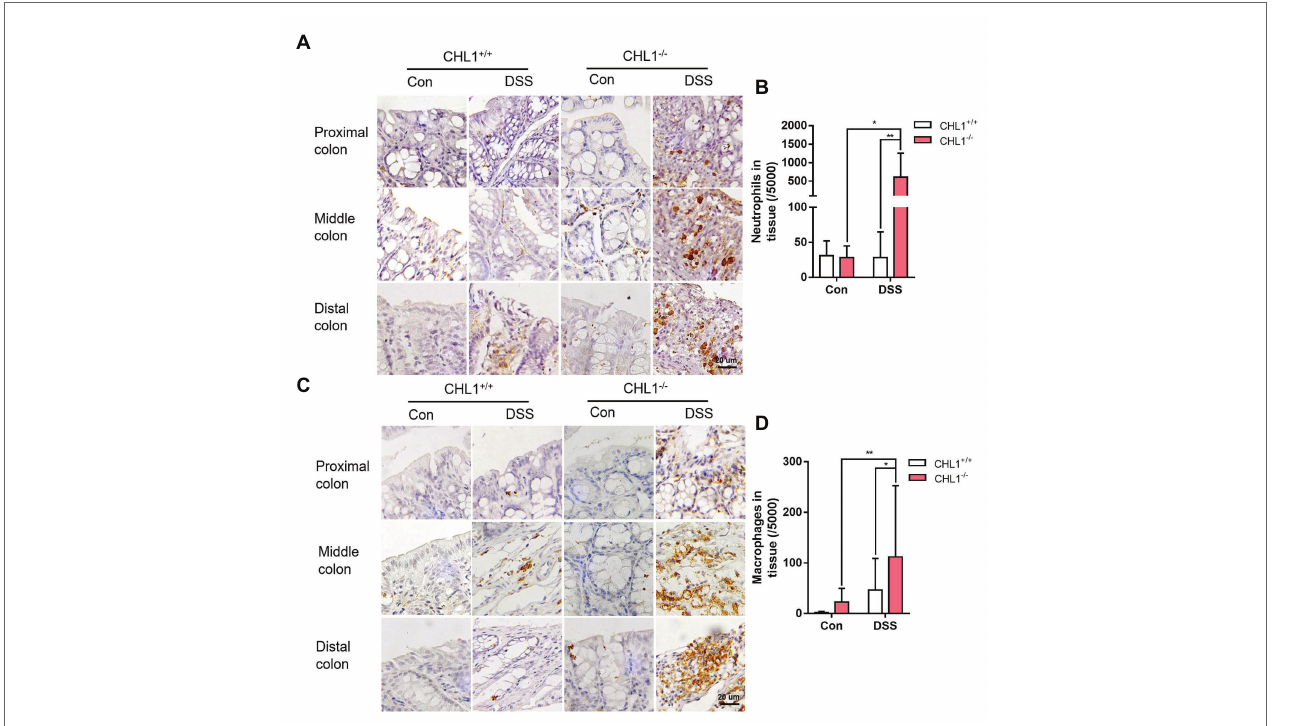
FIGURE 4 | CHL1 deficiency induced inflammatory cell infiltration (A,B) Representative immunohistochemical images (A) and analysis (B) of Ly6B.2-stained colon tissue from DSS-exposed CHL1 +/+ and CHL1 −/− mice (* p < 0.05, ** p < 0.01, n = 5/group). (C,D) Representative immunohistochemical images (C) and analysis (D) showing F4/80 staining in CHL1 +/+ and CHL1 −/− mice exposed to DSS (* p < 0.05, ** p < 0.01, n =